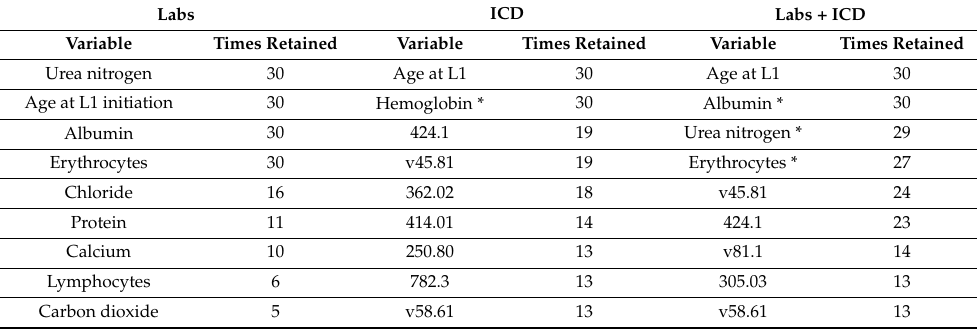
Table A5. Number of times (out of 30 splits) that different variables were retained in the regularized Cox model after lasso regularization, with different datasets.